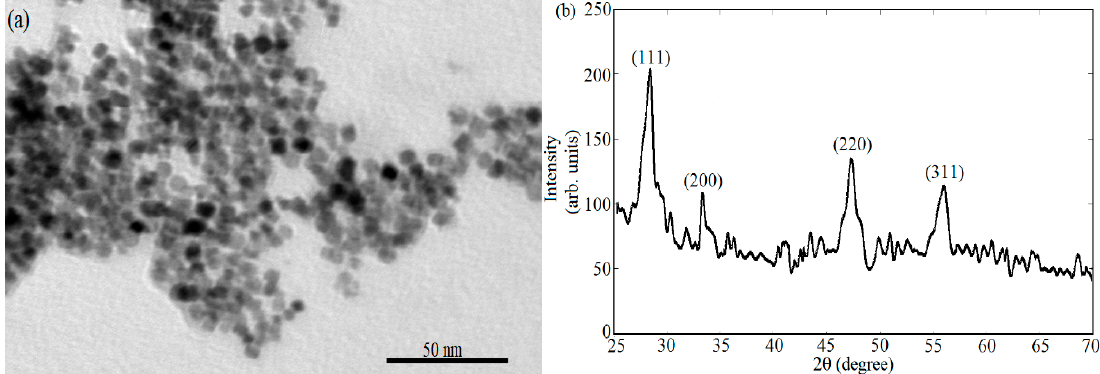
Figure 4. ( a ) TEM image of in-situ added gold-ceria nanoparticles, and ( b ) XRD pattern of gold-ceria Figure4. ( a )TEMimageofin-situaddedgold-ceriananoparticles, and( b )XRDpatternofgold-ceriaNPs. NPs.